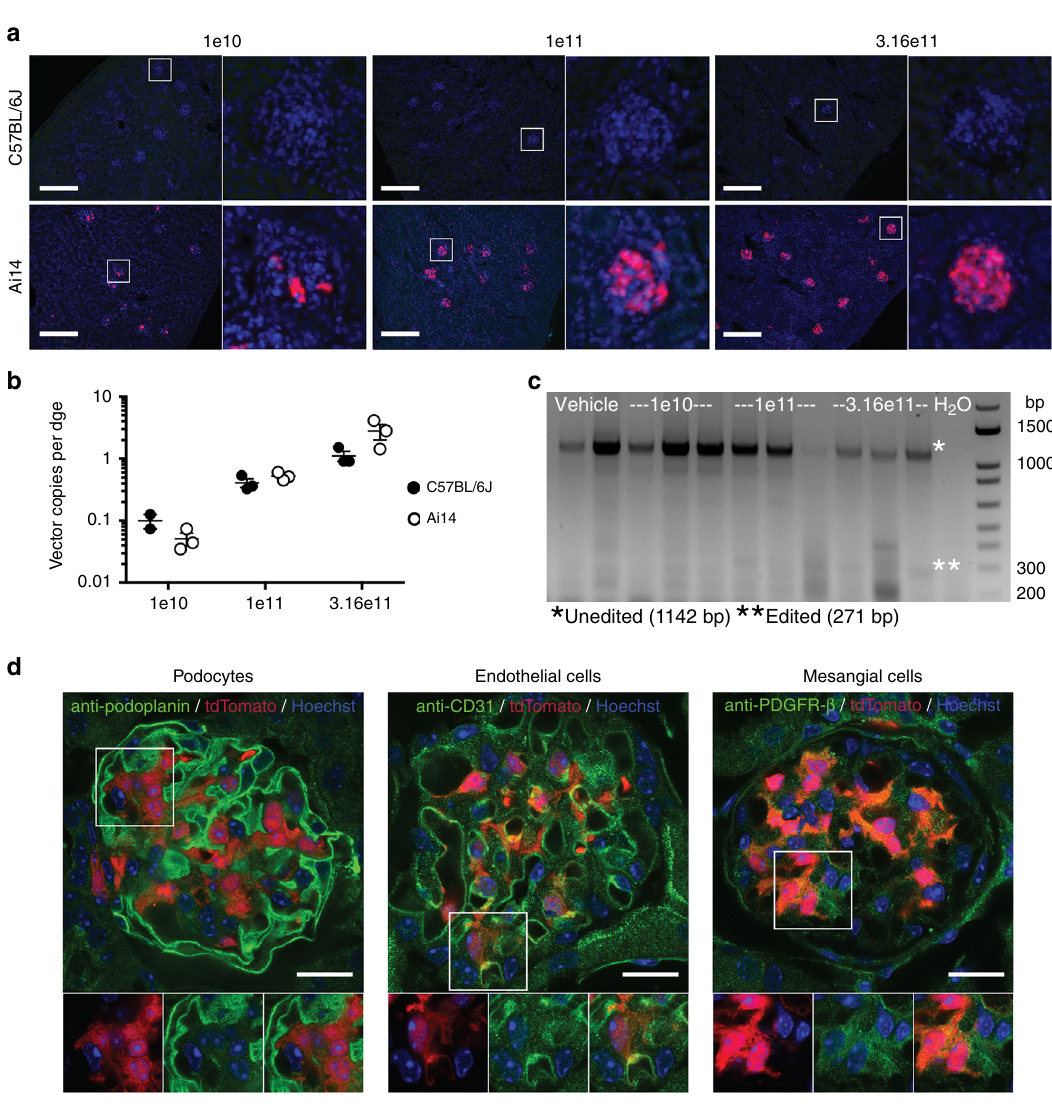
Fig. 3 AAV8 transduces kidney glomeruli. a Representative fl uorescent photomicrographs of kidney sections from C57BL/6J and Ai14 mice 2 weeks after IV delivery of AAV8-Cre-eGFP at the indicated doses. No eGFP expression is detected in green channel in either mouse strain for all doses tested. tdTomato (red) indicates editing; nuclei are shown (blue). n = 2 – 3 for C57BL/6J mice, n = 3 for Ai14 mice. Scale bars = 250 µ m. b Comparison of AAV vector copies per diploid genome equivalent (dge) in kidney samples from C57BL/6J and Ai14 mice 2 weeks post IV delivery. Values for individual mice are shown along with the mean and standard error for each strain and dose group. c Cre-mediated recombination at the ROSA26 locus as detected by PCR assay of kidney genomic DNA from Ai14 mice. d Immunohistochemistry for glomerular cell types in Ai14 mice 2 weeks after AAV8-Cre-eGFP delivery (3.16e11 vg). Primary antibodies labeled podocytes (anti-podoplanin), endothelial cells (anti-CD31), and mesangial cells (anti-PDGFR- β ) and were detected with Alexa-488 conjugated secondary antibodies (green). Cre-tagged cells are tdTomato positive. Scale bars = 25 µ m. Source data are provided as